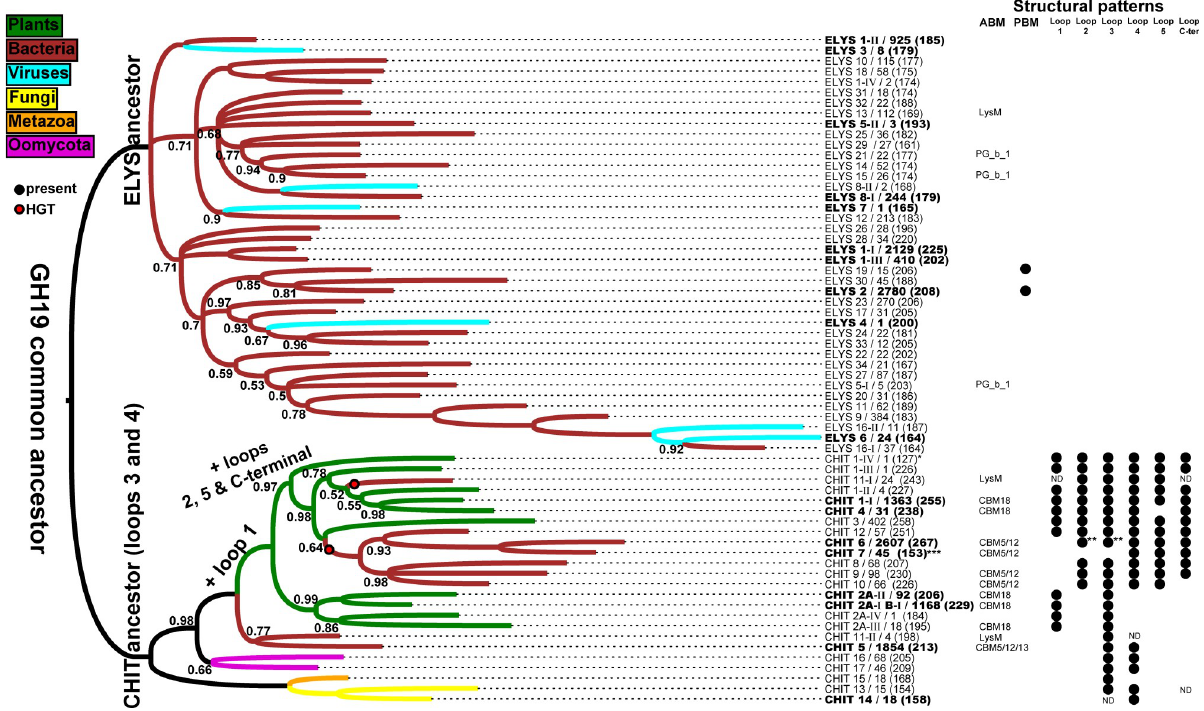
Fig 5. Phylogeny of centroids representative of GH19 sequence space, plotted on structural patterns analyzed in this study. Sequences are indicated with the respective subfamily name (ELYS or CHIT) followed by the group identifier (homologous family in GH19ED database) / number of represented sequences, followed by sequence length of the centroid in parentheses. Sub-clusters according to S15 and S16 Figs are reported as Roman numerals. Sequences representing clusters that contain characterized seed sequences are depicted in bold. � This centroid sequence is a fragment. �� A fraction of sequences from group CHIT 6 has longer loops (see Table 3 ). ��� All sequences from group CHIT 7 have a different N-terminal portion in their catalytic domain. HGT = horizontal gene transfer; ABM = accessory binding module; PBM: 3-helix peptidoglycan binding bundle; PG_b_1 = PG_binding_1; CBM = carbohydrate binding module; ND = not defined because too variable within the group (homologous family). The numbers at internal nodes indicate posterior probabilities only if < 1; internal nodes are collapsed if posterior probability is less than 0.5. ELYS 1 = Pseudomonas prophage like; ELYS 2 = Salmonella typhimurium like; ELYS 3 = Salmonella phage PVP-SE1 like; ELYS 4 = Ralstonia phage like; ELYS 5 = Pseudomonas phage OBP like; ELYS 6 = Acinetobacter phage like; ELYS 7 = Mycrocystis phage like; ELYS 8 = Mycobacterium phage like; ELYS 9 to 34 = other putative endolysins from phages and prophages; CHIT 1 = plant “loopful”; 2a-b = plant “loopless”; CHIT 3 = plant CLP with regulatory function; CHIT 4 = Urtica dioica like CLP lectins; CHIT 5 = bacterial “loopless”; CHIT 6–7 = Proteobacteria ; CHIT 8 to 12 = other putative bacterial chitinases; CHIT 13–14 = Fungi ; CHIT 15 = Metazoa ; CHIT 16–17 = Oomycota